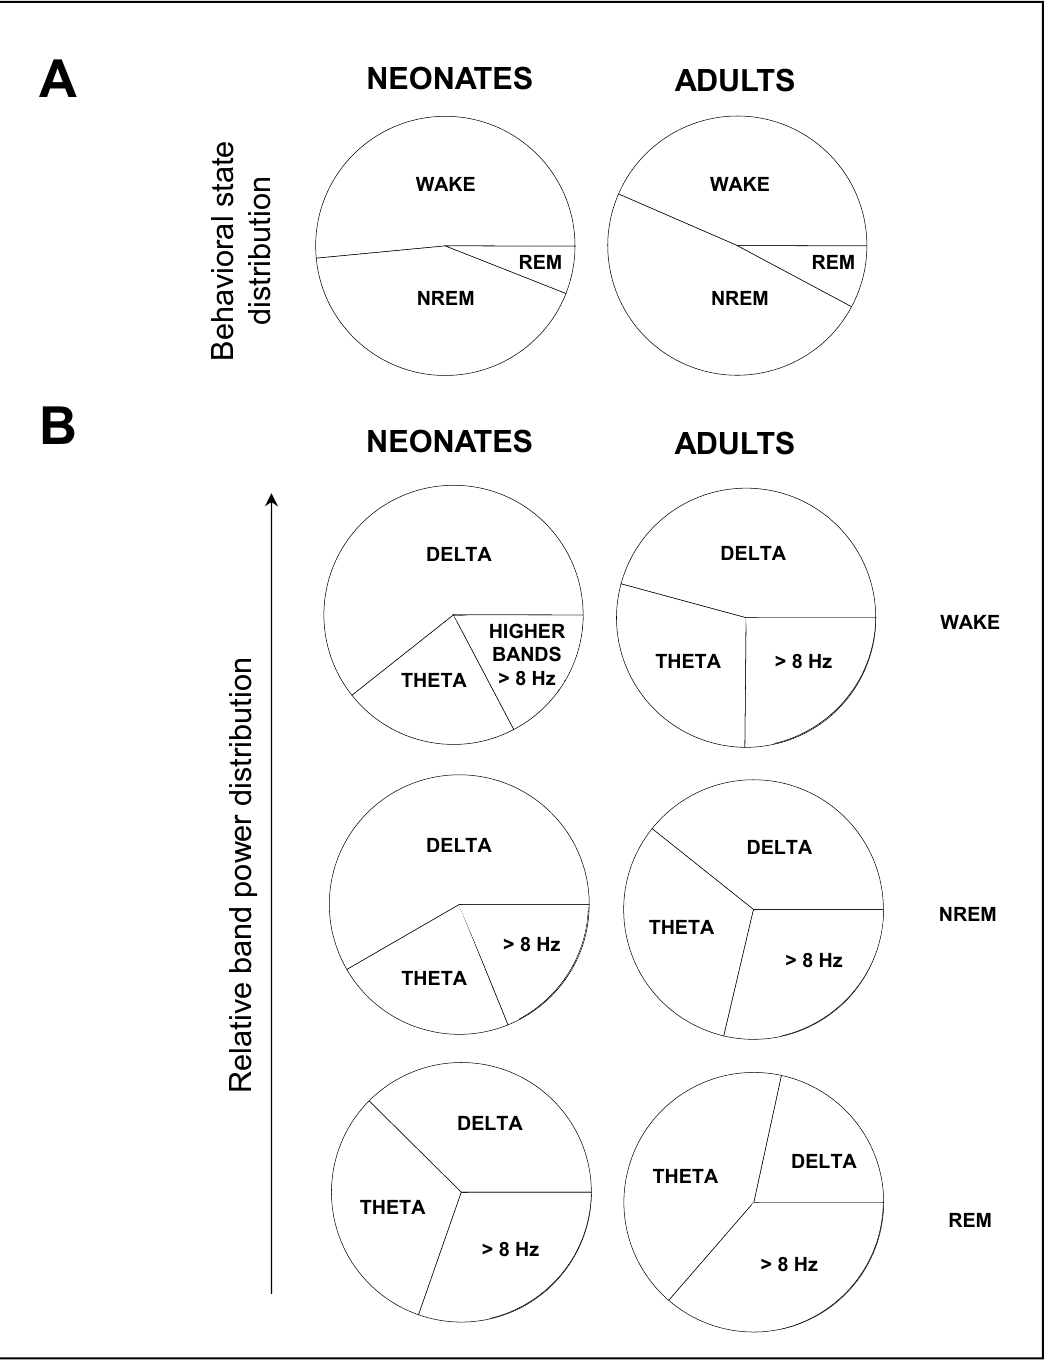
Figure 5. Main findings on the sleep–wake cycle patterns during neonate to adult transition. Data shown from the 12 h- light phase, whose trends are representative of those from the 12 h-dark phase. ( A ) Late neonatal mice spent more time in wakefulness and less time in NREM sleep. ( B ) Late neonatal mice showed an increased relative δ band power, and a reduced relative θ band power—and β band power during wakefulness and NREM sleep—compared to adult mice. Data shown as mean ± SEM of either 18 or 27 recordings retrieved from 6 neonatal or 11 adult mice,